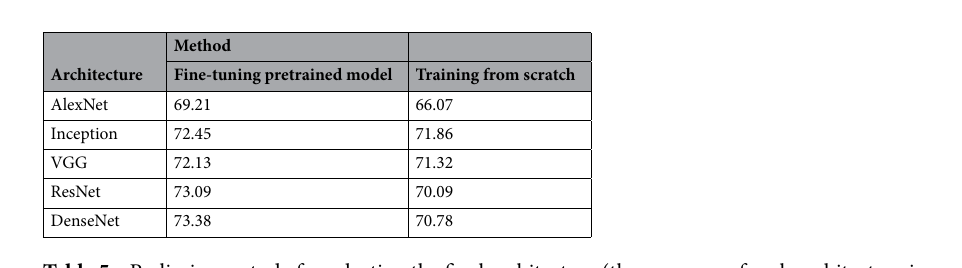
Table 5. Preliminary study for selecting the final architecture (the accuracy of each architecture is reported as a percentage